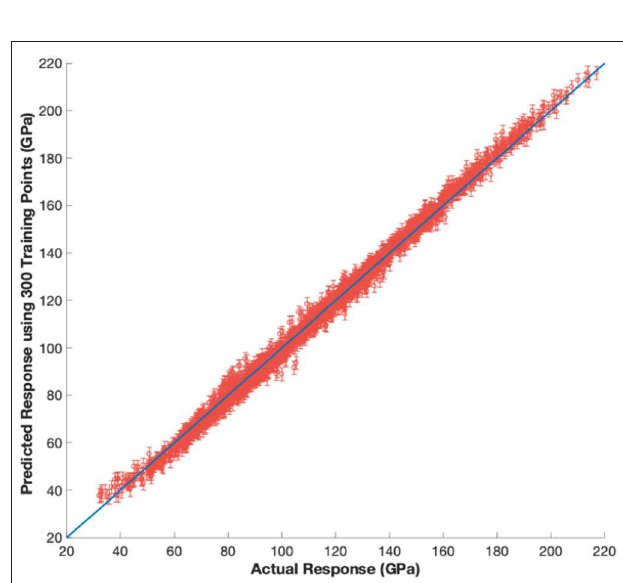
FIGURE 3 | Predictions for the 1986 FE simulated indentation moduli not used in the training of the reduced-order model. A single standard deviation from the predicted mean is also shown in the plot for each